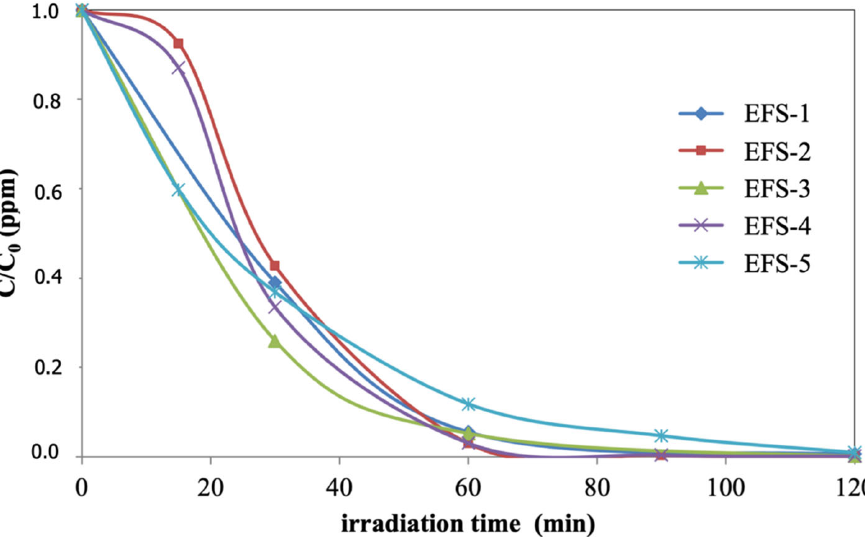
Figure 10. Wastewater pollutant degradation by photocatalysis using black sand as a photocatalyst and sunlight activating the photocatalyst (expressed in C/C 0 units) for several experiments under varying solar irradiation (experimental conditions in Table 3). Table 3. Operating conditions of photocatalytic experiments using black sand as photocatalyst and solar radiation as light source. Exp.